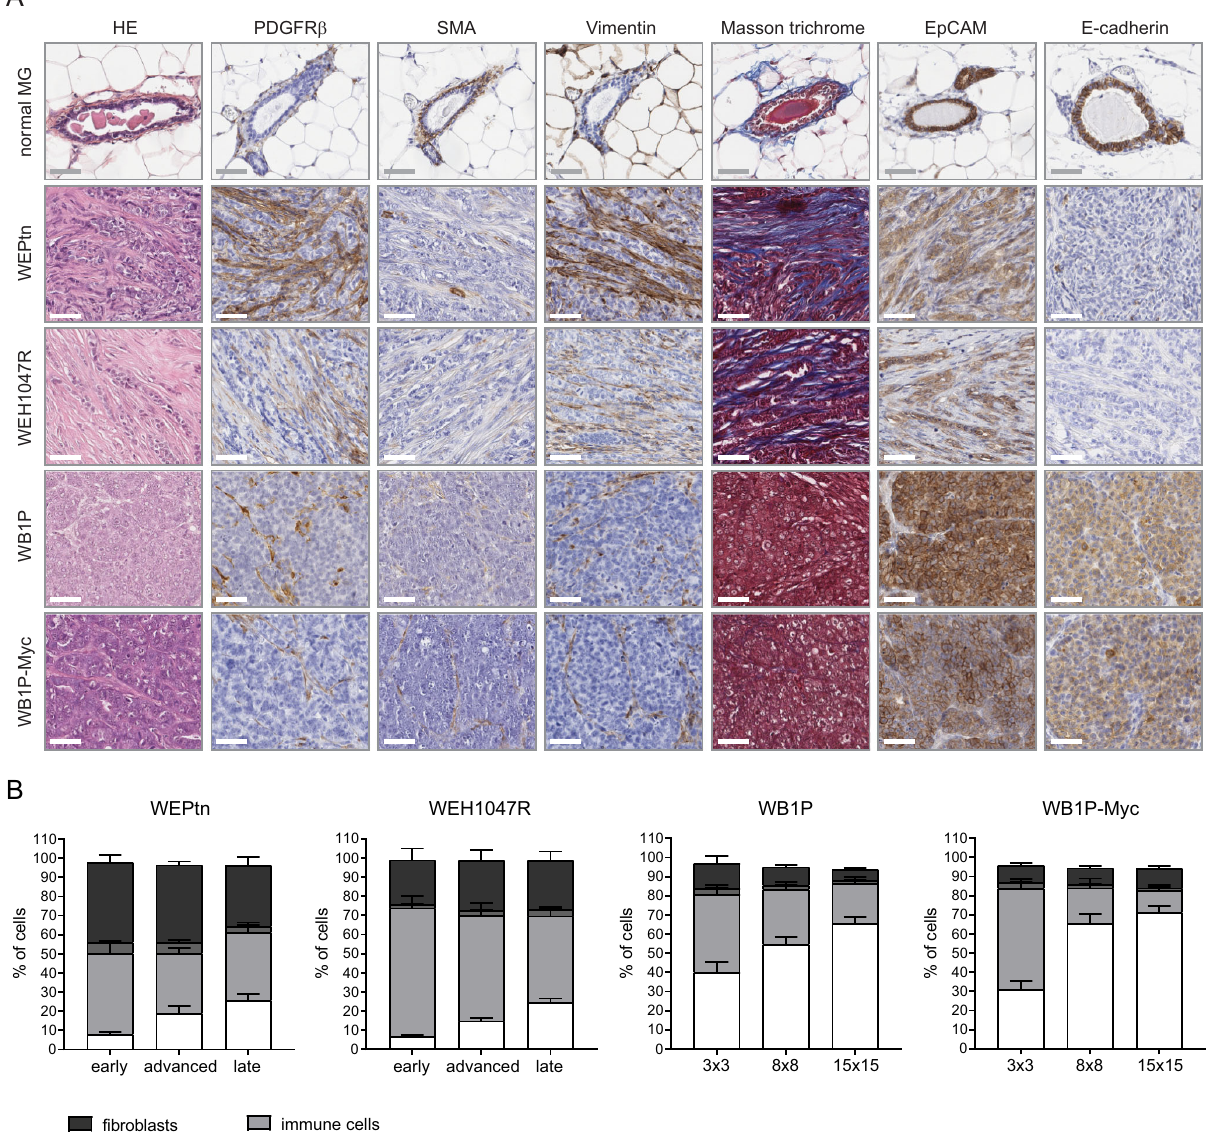
Fig. 1 | TNBC and ILC differ in histology and quantity of CAFs. A HE and immunohistochemical stainings of non-tumor bearing control mammary glands and tumors derived from ILC mouse models (WEPtn and WEH1047R) and TNBC mouse models (WB1P and WB1P-Myc) for fi broblast markers (platelet-derived growth factor receptor beta:PDGFR β , alpha smooth muscle actin: SMA,vimentin), collagen(Masson trichrome) and epithelialcells (epithelialcelladhesionmolecule: EpCAMandE-cadherin).Imagesarerepresentativesof n =4micepertumormodel. Scalebarsare50um. B Flowcytometryanalysisoftumorcompositionatindicated stagesoftumordevelopment(WEPtnandWEH1047R)ortumordimensionsinmm